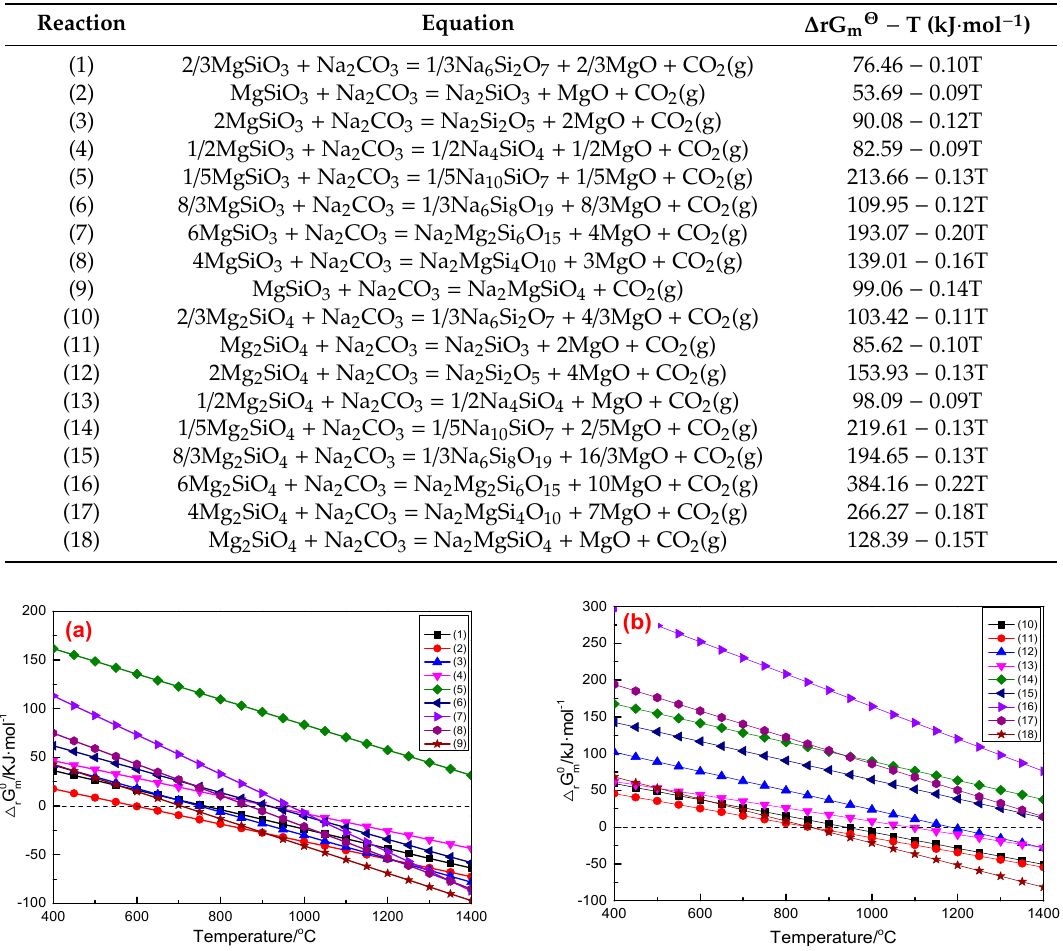
Table 2. ∆ rG m Θ − T equations of Na 2 CO 3 ‐ MgO ‐ SiO 2 system during roasting (400 °C < T < 1400 °C)